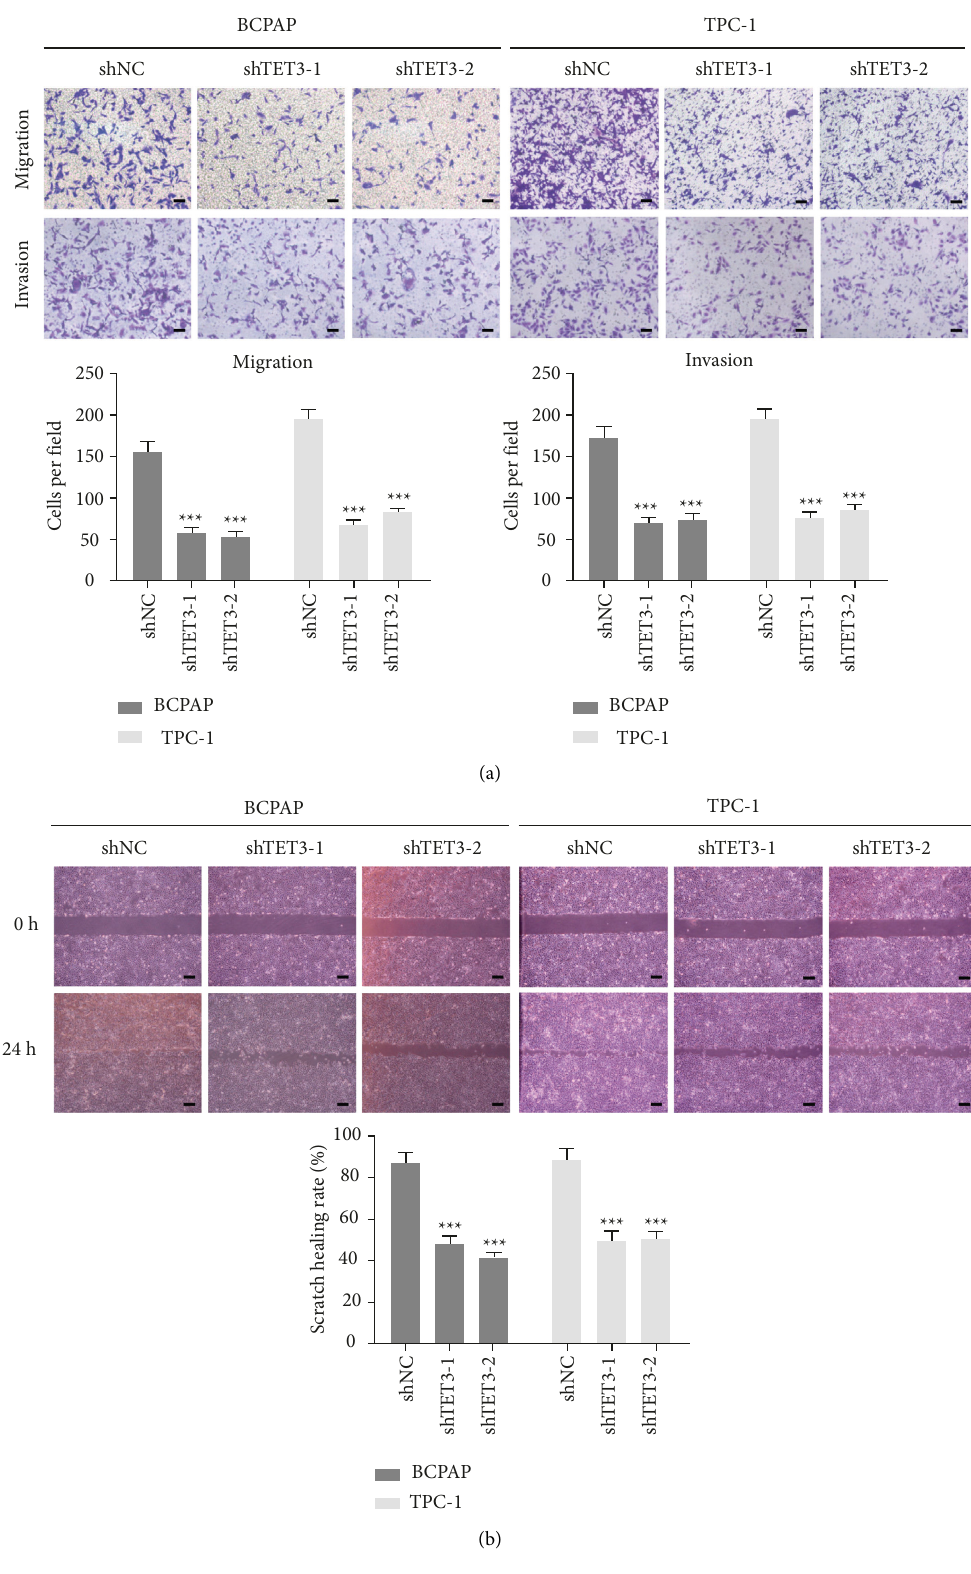
Figure 4: (a) The results of transwell tumor migration test showed that inhibition of TET3 expression significantly reduced the invasion ability of BCPAP and TPC-1 fine cell lines; (b) Representative images of wound-healing assays using BCPAP and TPC-1 cells showed that inhibition of TET3 expression significantly reduced the migration ability. Scale bars: 25 μ m. The plots below show the quantification of wound-healing assays. Data are shown as mean ± s.d. ( n ≥